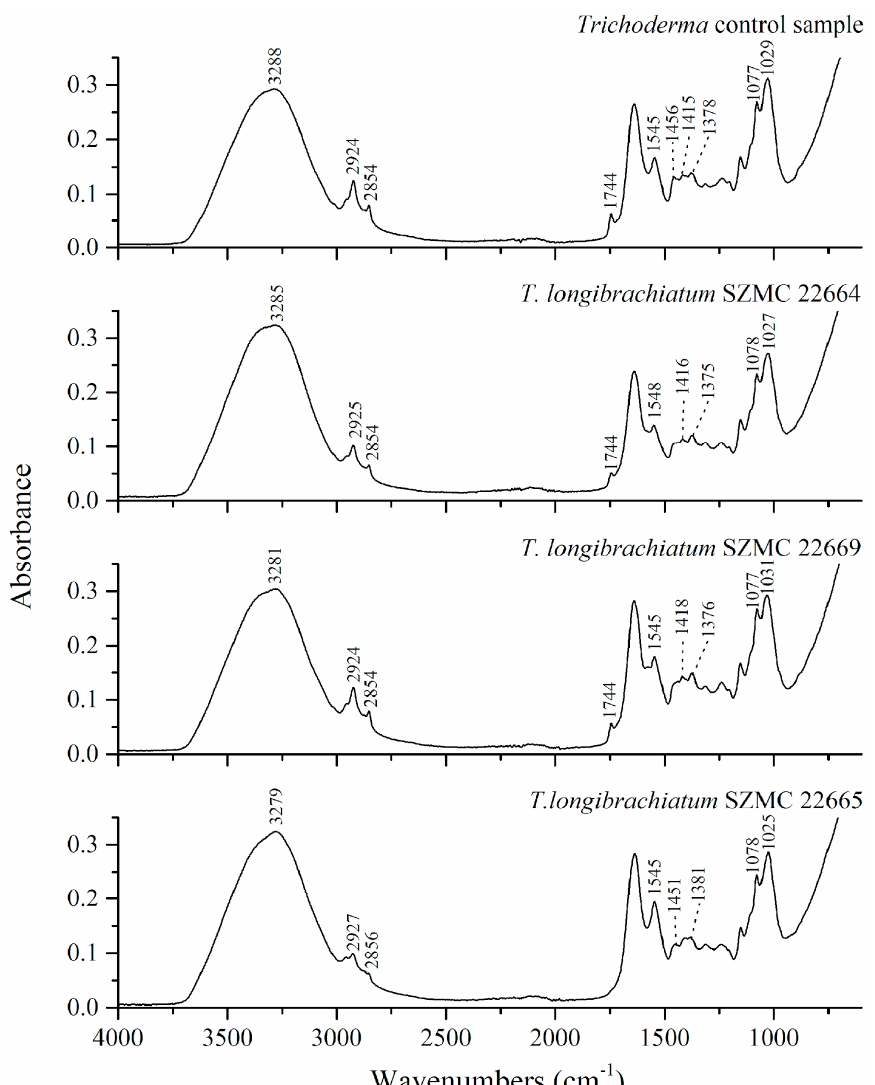
Figure 2. Stacked FTIR spectra of Trichoderma control cell group and strains 22664, 22669, and 22665 grown in 60 mg/L PDA medium of Ni. Table 4. Wavenumbers (cm − 1 ) and assignments of FTIR bands for Trichoderma fungal cells grown on clear PDA (control) and the PDA containing 60 mg/L Ni or Cu solutions.